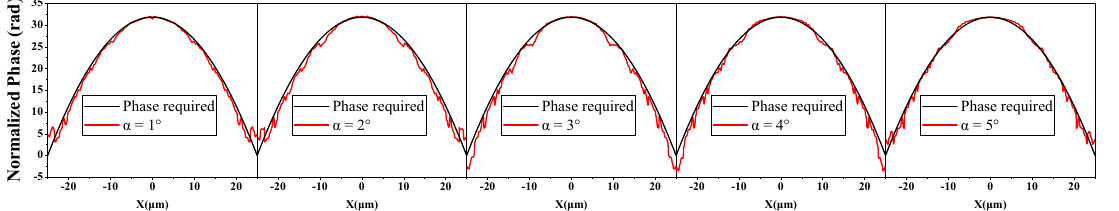
Figure 7. The required phase profile (black curve) and the computed phase profile of the metalenses (red curve) with different values of α.